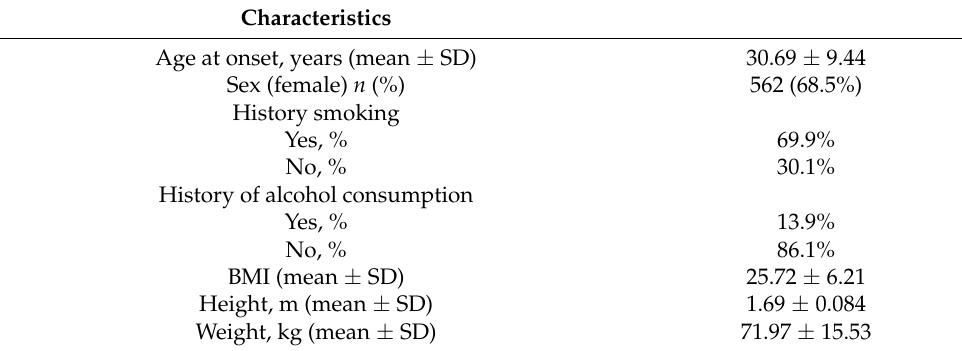
Table 1. Demographic characteristics of patients with RRMS ( n =